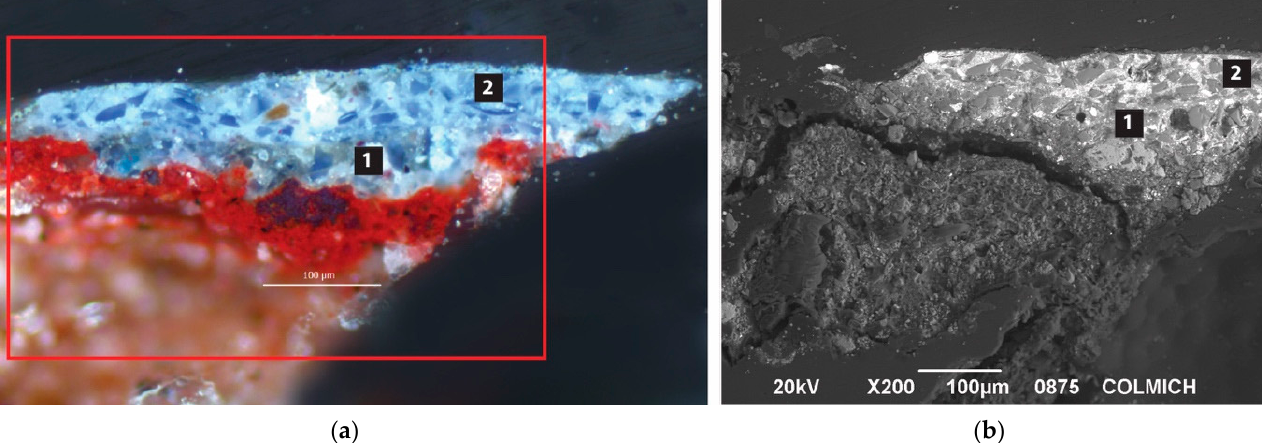
Figure 3. Cross-section from the sky in El Triunfo de la Iglesia . ( a ) Under the optical microscope (20×), it is possible to see the two layers rich in blue smalt (1 and 2). ( b ) In the SEM image (200×), particles of smalt appear as opaque pieces of glass mixed with lead white. Images by LADiPA-COLMICH.